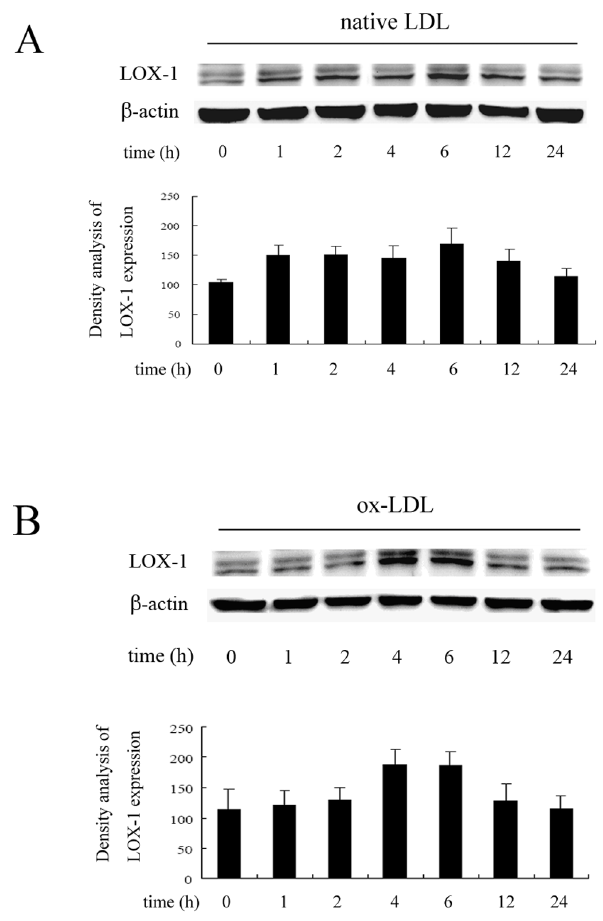
Figure 1. LOX-1 expression induced by native LDL or ox-LDL at different time points. (A) Native LDL-induced LOX-1 expression. (B) ox-LDL-induced LOX-1 expression. The results were obtained from three independent experiments.